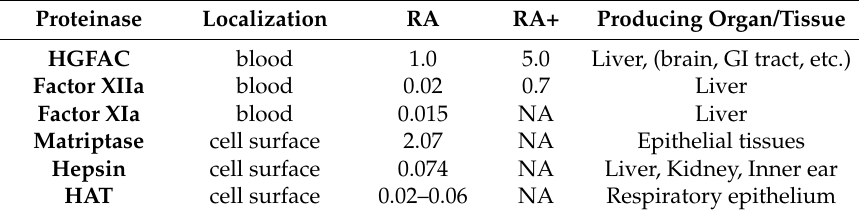
Table 1. Major proHGF-activating proteinases